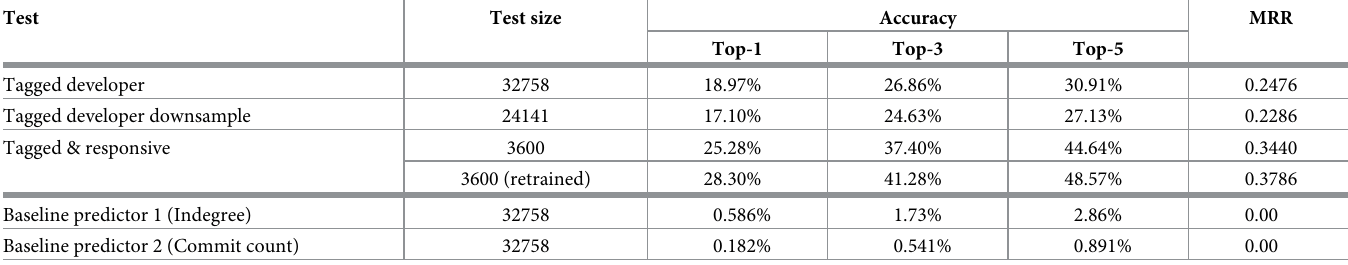
Table 4. Recommendation accuracy results on the full